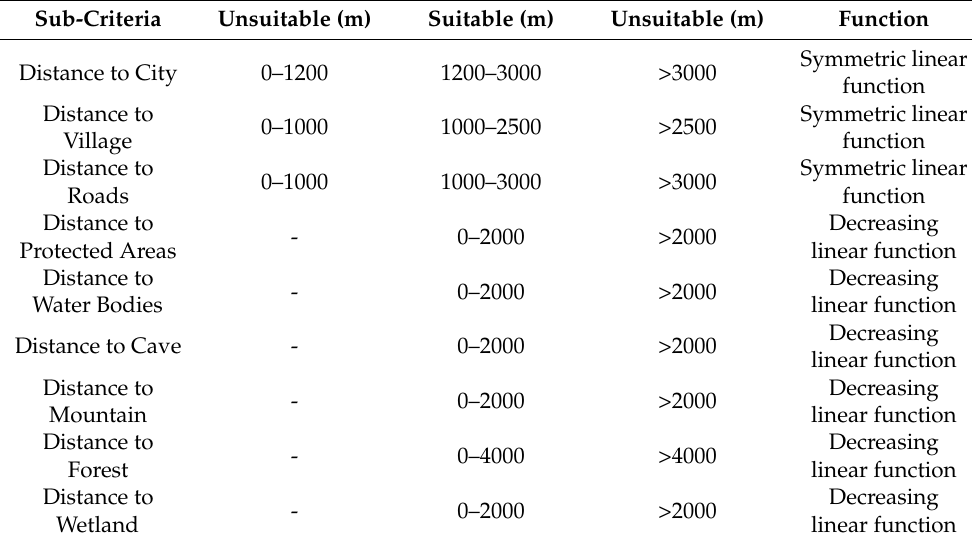
Table 1. The threshold quantities of the sub-criterion and the types and shape of the membership function.